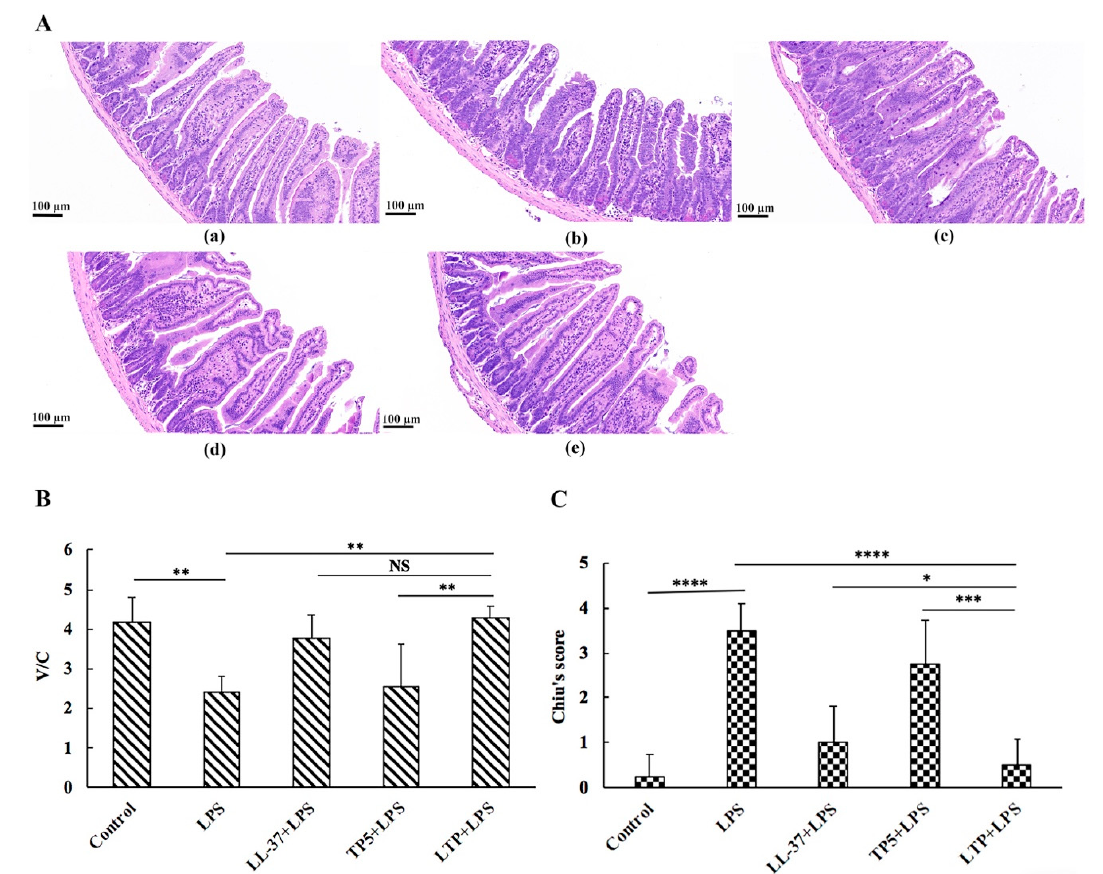
Figure 4. The protective effects of LTP against LPS-induced clinical symptoms in the jejunum. Representative H&E-stained sections from the ( A - a ) control, ( A - b ) LPS, ( A - c ) LL-37 + LPS, ( A - d ) TP5 + LPS, and ( A - e ) LTP + LPS groups. Bar, 100 μ m. ( B ) The effect of LTP on Chiu’s scores. Chiu’s score is comprised of changes of the villus and glands of the jejunal mucosa. ( C ) Protective effect of LTP on the ratio of villus height to crypt depth (V/C). Data are presented as the mean value ± standard error from 12 biological replicates. NS: p > 0.05, *: p ≤ 0.05, **: p ≤ 0.01, ***: p ≤ 0.001, ****: p ≤ 0.0001 .